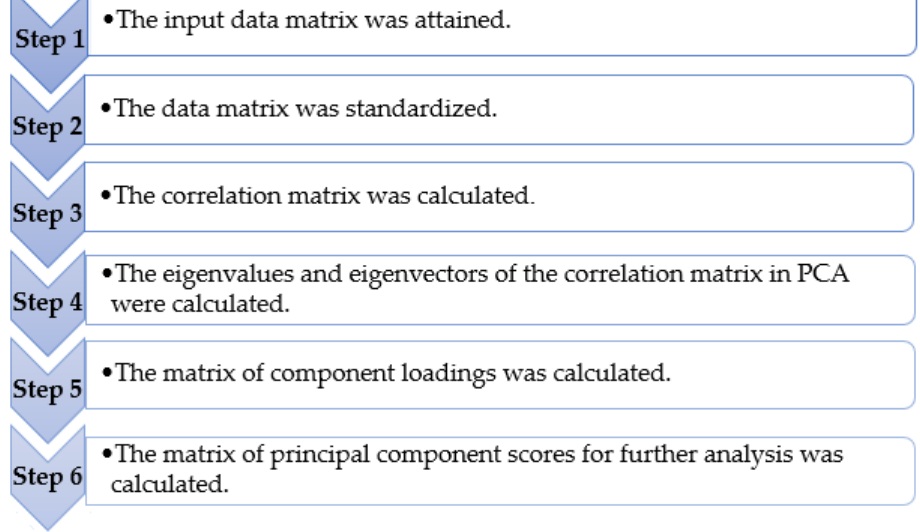
Figure 2. Procedure of classical PCA.